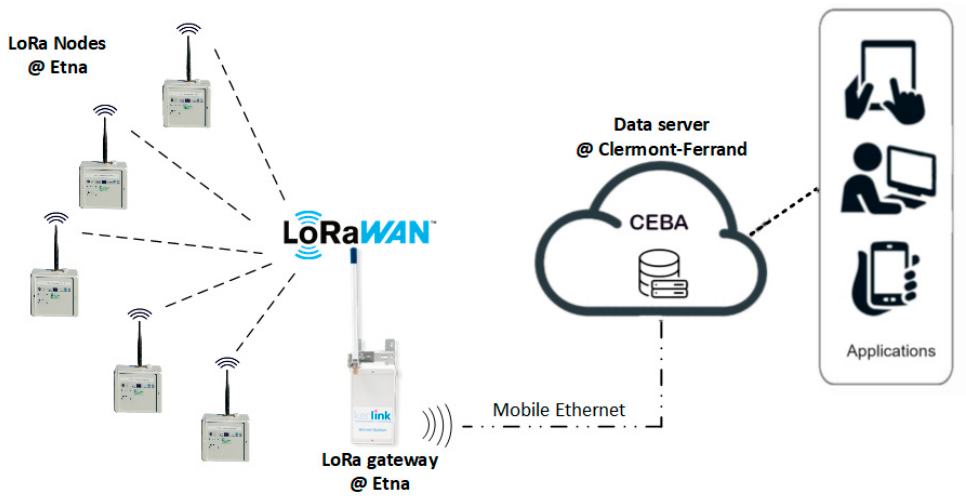
Figure 4. LoRaWAN (wide-area network) topology deployed from the LoRa nodes to the server (called CEBA).